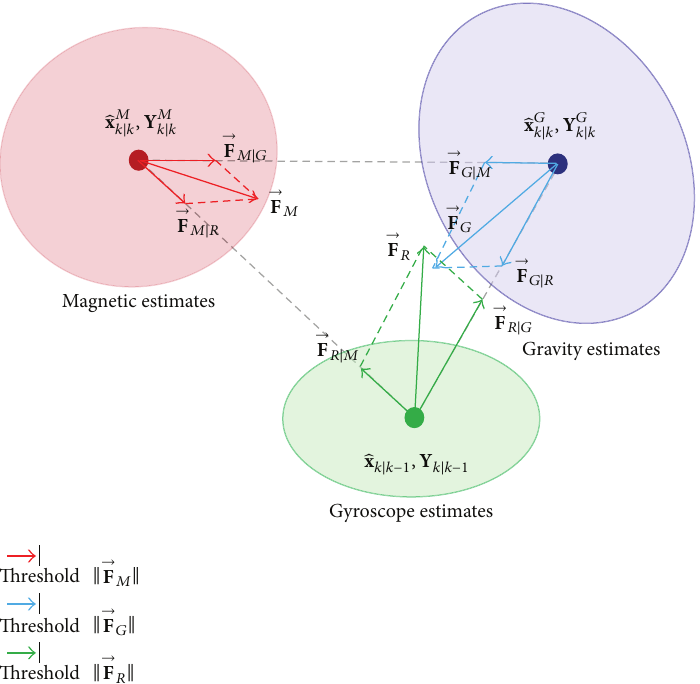
Figure 1: Fault Detection, Identification, and Accommodation